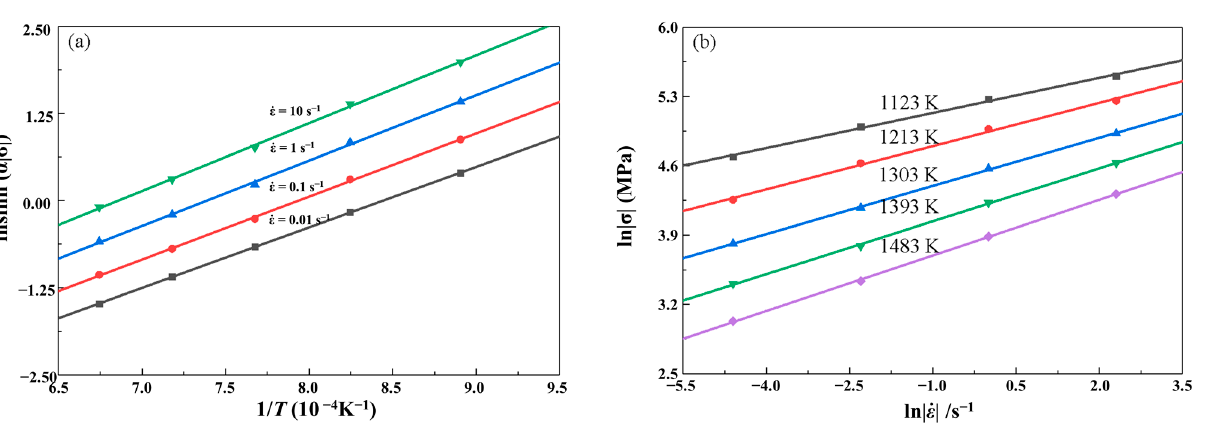
Figure 7. Relationships between: ( a ) lnsinh [ α | σ | ] and 1/ T ; ( b ) lnsinh [ α | σ | ] and ln|𝜀(cid:4662)| . Equation (10) can also be expressed as following: